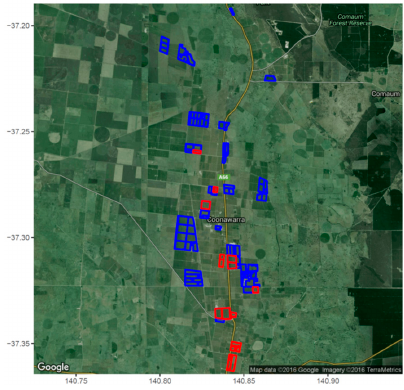
Figure 1. Regional vineyards in Coonawarra, South Australia surveyed by airborne remote sensing (red and blue regions) and a subset of those that were ground-truthed (red regions). The distance from north to south of the map is approx. 20 km.